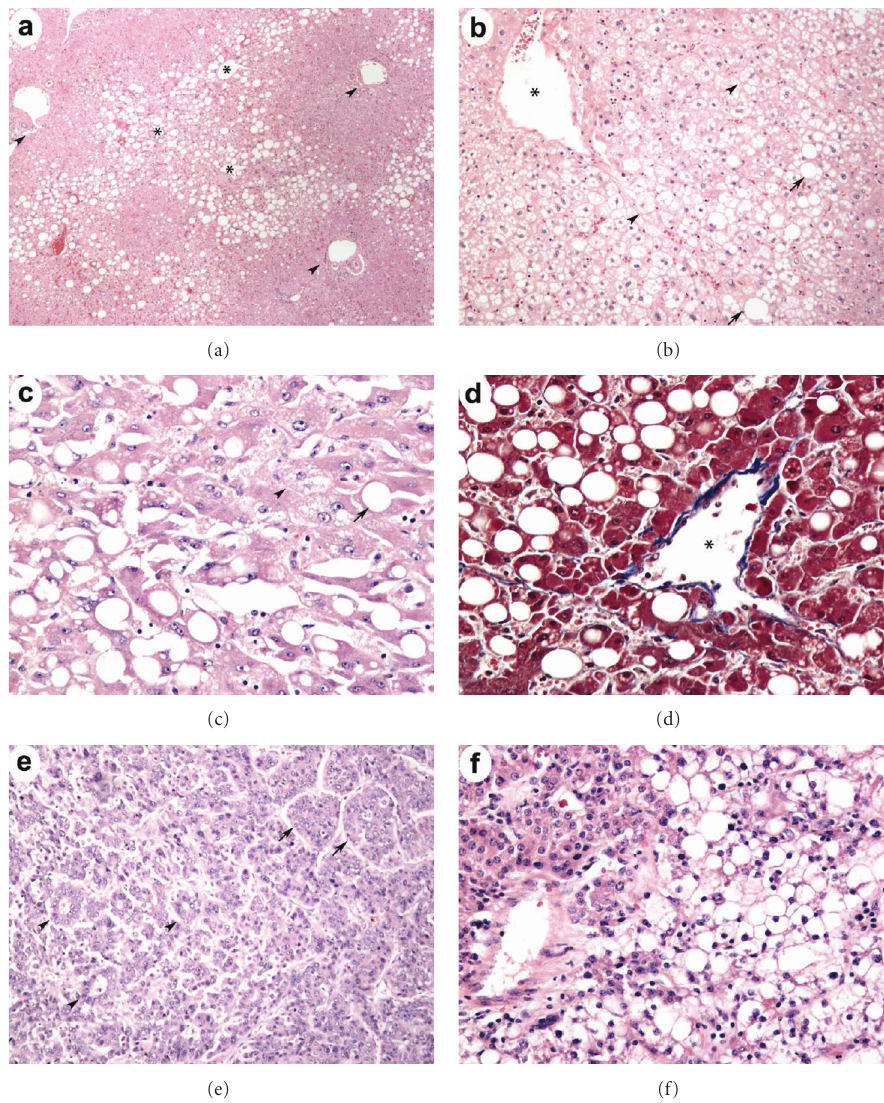
Figure 2: Histopathological features of noncirrhotic NASH-associated HCC. (a) The nonneoplastic liver shows macrovesicular steatosis involving the perivenular zone ( ∗ ) with sparing of the periportal zones (arrowheads) (patient 8, H&E stain, 40x). (b) and (c) show at greater magnification the steatotic hepatocytes (arrows) and ballooning degeneration of hepatocytes (arrowheads) evident in the perivenular zone of the nonneoplastic parenchyma (patients 4 and 7, H&E stain, 100x and 200x). (d) Specialized collagen staining shows the central venule ( ∗ ) to be invested with a band of perivenular fibrosis; bridging fibrosis and cirrhotic nodules are notably absent (patient 7, Masson’s trichrome stain, 200x). (e) and (f) show two examples of HCC arising within noncirrhotic NASH showing pseudoglandular (arrowheads) and trabecular (arrows) features and fat within tumor cells (right frame) (patients 7 and 8, H&E stain,